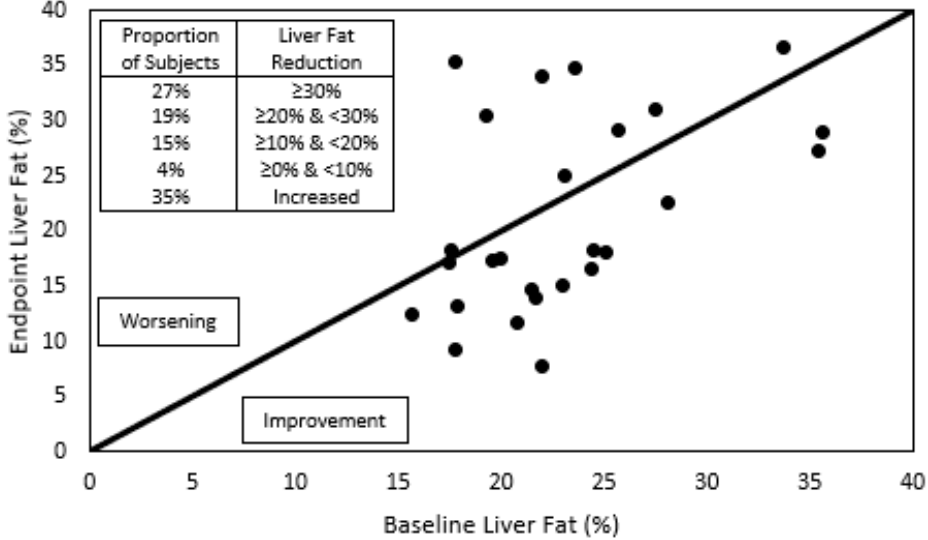
Figure 2. Individual liver fat content before and after phytosterol treatment. To the right of the diagonal line are located individuals whose liver fat improved after the one-year treatment with submicron dispersible phytosterols, and to the left, those who worsened. The insert indicates the proportion of subjects that showed a reduction in liver fat greater than 30%, between 30 and 20%, between 20 and 10%, between 10 and 0%, or those who showed an increase in liver fat.